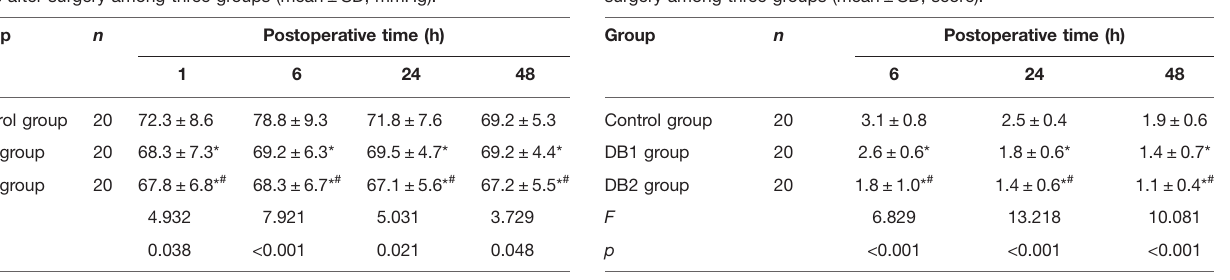
TABLE 6 | Comparison of VAS scores of puerperae at different times after surgery among three groups (mean±SD, score).